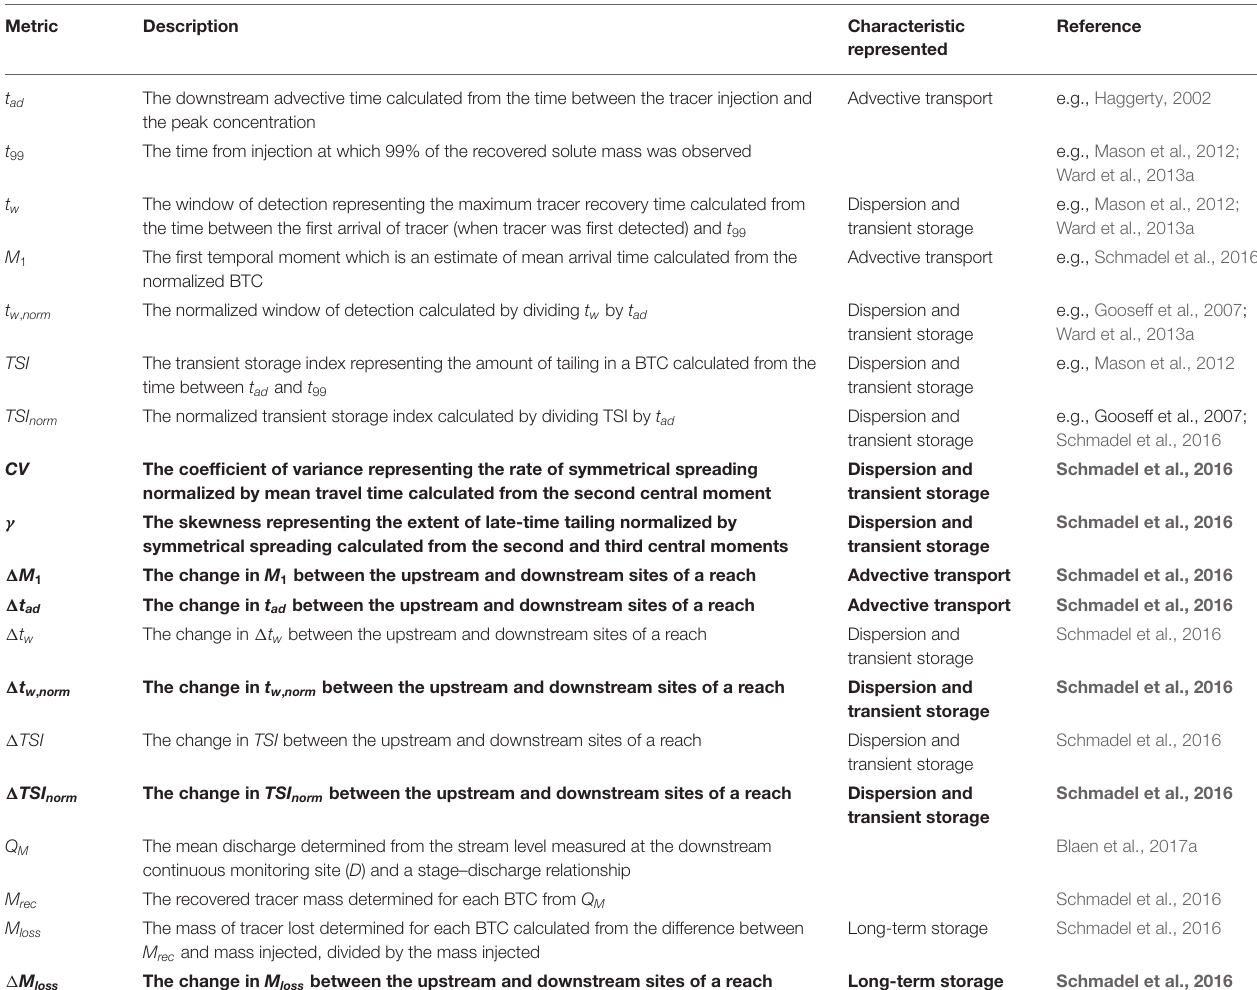
TABLE 2 | Details of the hydrological metrics presented here, including descriptions and how they were calculated. Metric